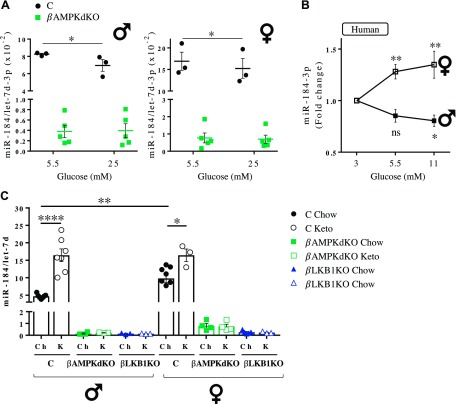
AMPK mediates glucose-dependent regulation of miR-184. miRNA expression was assessed by RT-qPCR in isolated islets from βAMPKdKO (green) and control (C, black) male (left side) and female (right side) mice cultured with 5.5 or 25 mM glucose for 48 h (A); male and female human donors cultured with 3, 5.5, or 11 mM glucose for 48 h (B); and βAMPKdKO (green), βLKB1KO (blue), and control (C, black) male and female mice fed chow (Ch) or a ketogenic (K) diet for 28 d (C). Ns, not significant. *P < 0.05, **P < 0.01, ****P < 0.0001 [Student’s t test (A, C) or 2-way repeated-measures ANOVA and Fisher least significance difference test (B)].